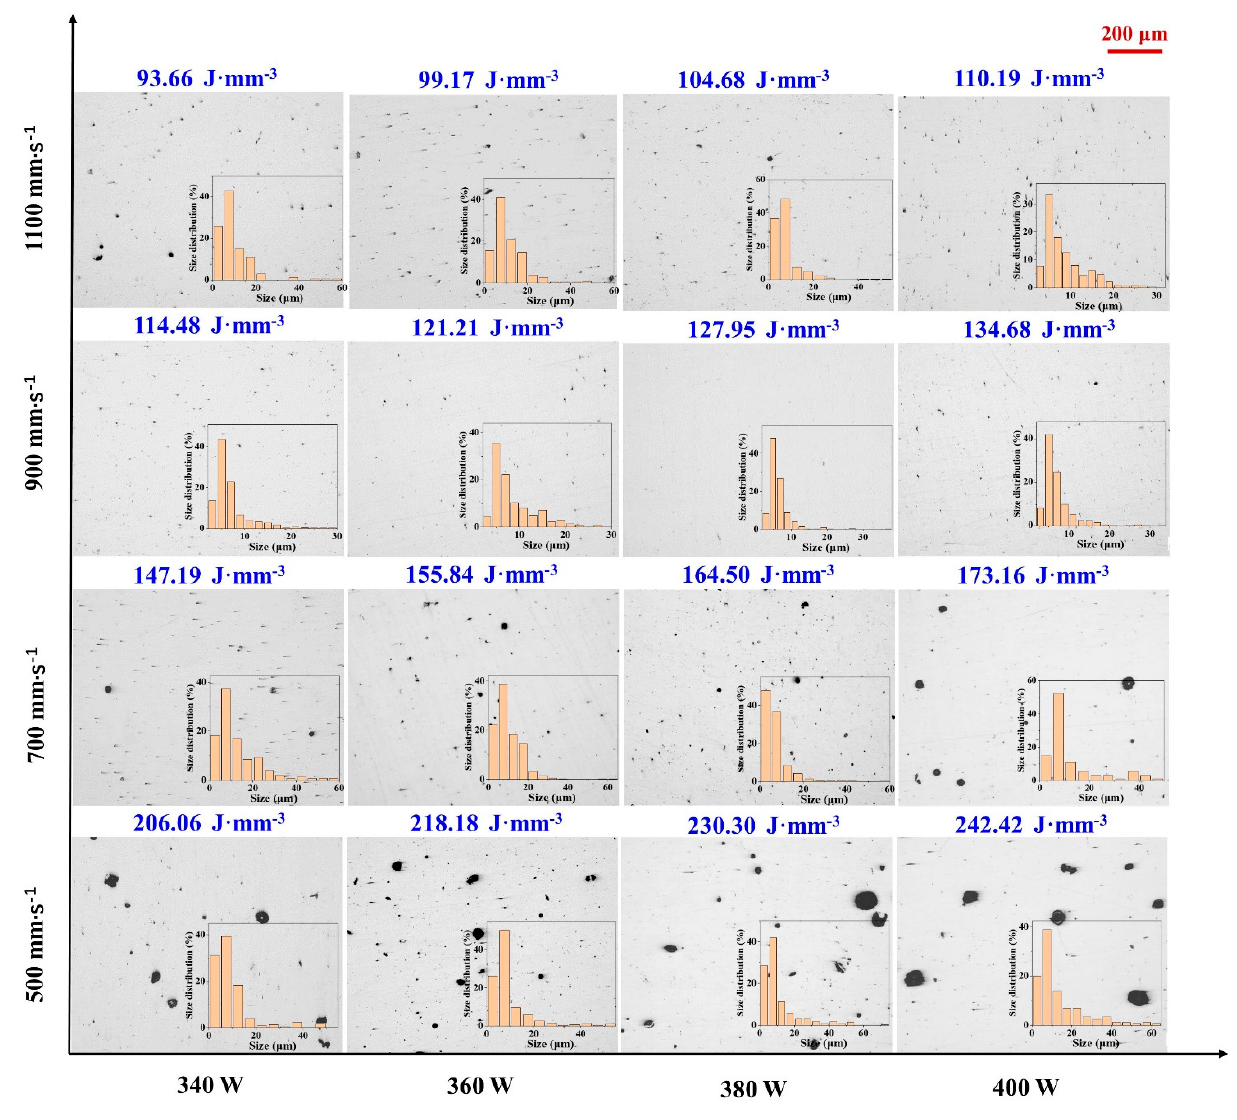
Figure 3. The morphology and the size distribution of pores of as-built samples with different process parameters.